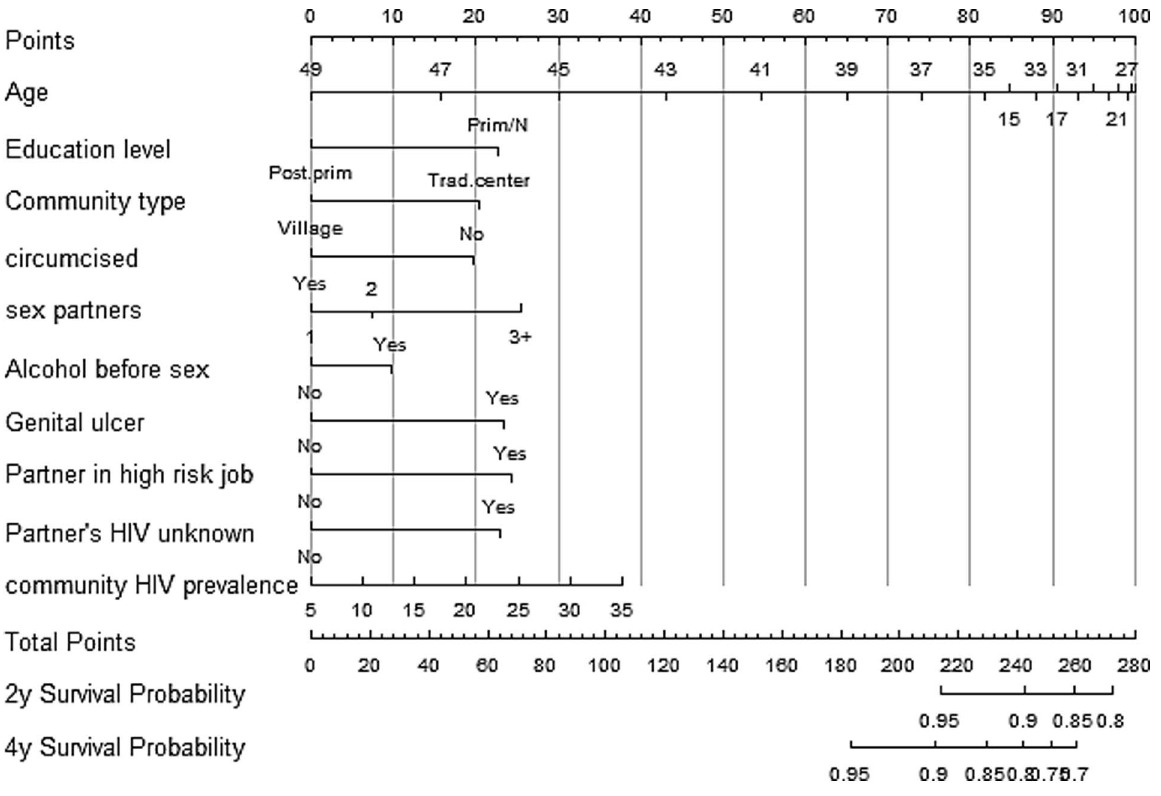
Figure 5. Nomogram of HIV risk for sexually active men developed using the Rakai cohort, Uganda 2003–2011.